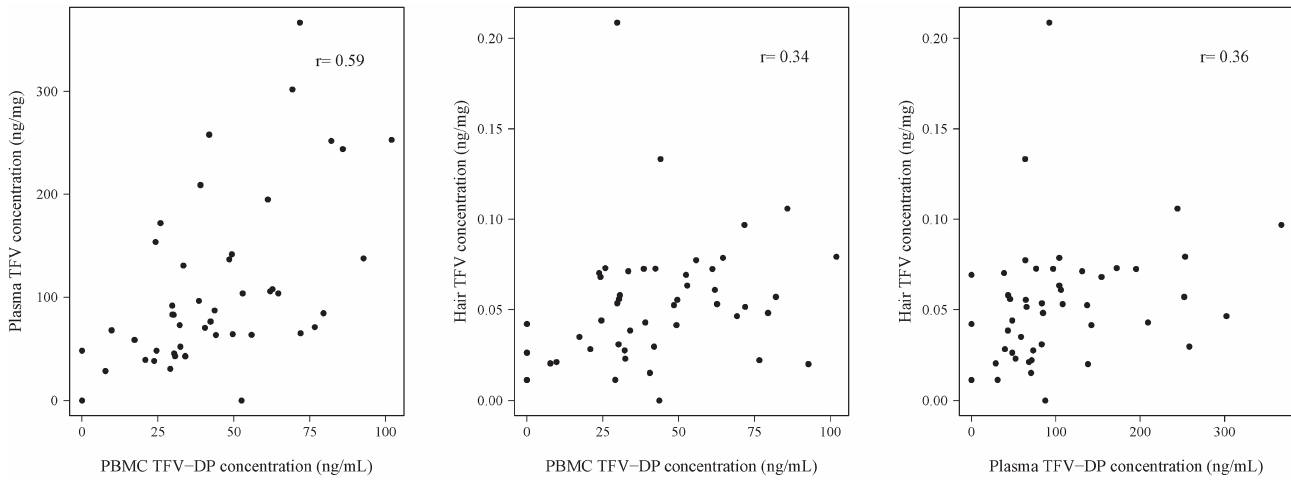
Fig 2. Scatterplots of PBMC TFV-DP concentration versus plasma TFV concentration (2a), PBMC TFV-DP concentration versus hair TFV concentration (2b) and plasma TFV concentration versus hair TFV concentration